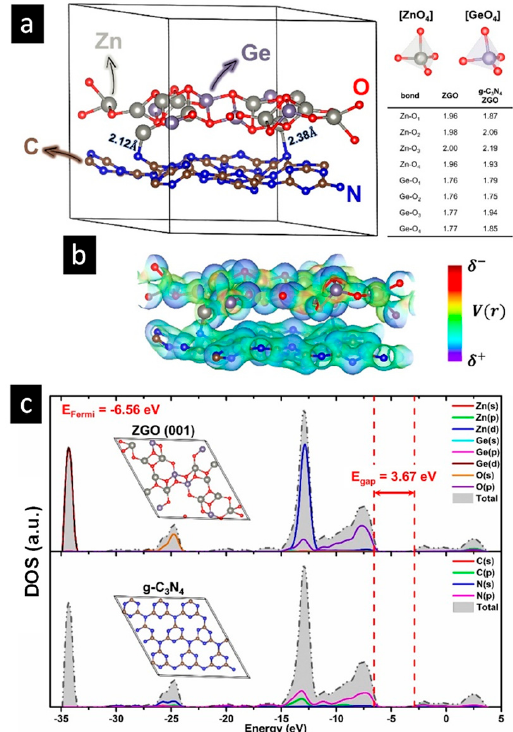
Figure 2. Theoretical assessment of the electronic structure of g-C 3 N 4 /Zn 2 GeO 4 nanocomposite. ( a ) Representative g-C 3 N 4 /Zn 2 GeO 4 (ZGO) nanocomposite unit cell, ( b ) Surface electrostatic potential [ V (r)] for the heterostructure (0.05 a.u. isodensity), where blue and red colors denote positive and